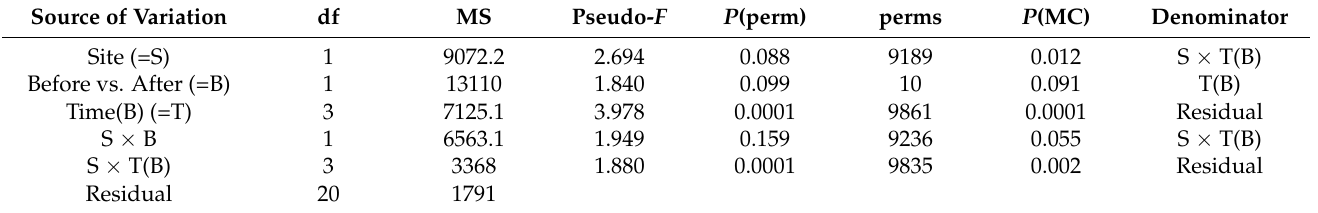
Table 3. PERMANOVA on benthic assemblages of Treatment and Control sites at Before (T1, T2) and three After (T3–T5) the bioremediating action. Abundances of taxa were square root trans- formed.